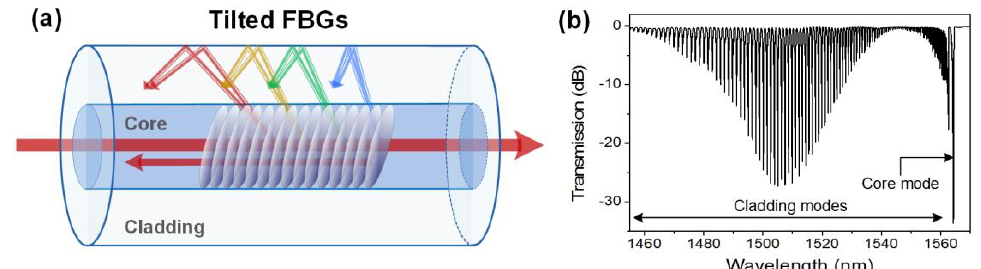
Figure 3. ( a ) Sketch of the light mode coupling in a tilted-fiber Bragg grating (TFBG); and ( b ) transmitted amplitude spectrum of a 1 cm-long 10° TFBG.